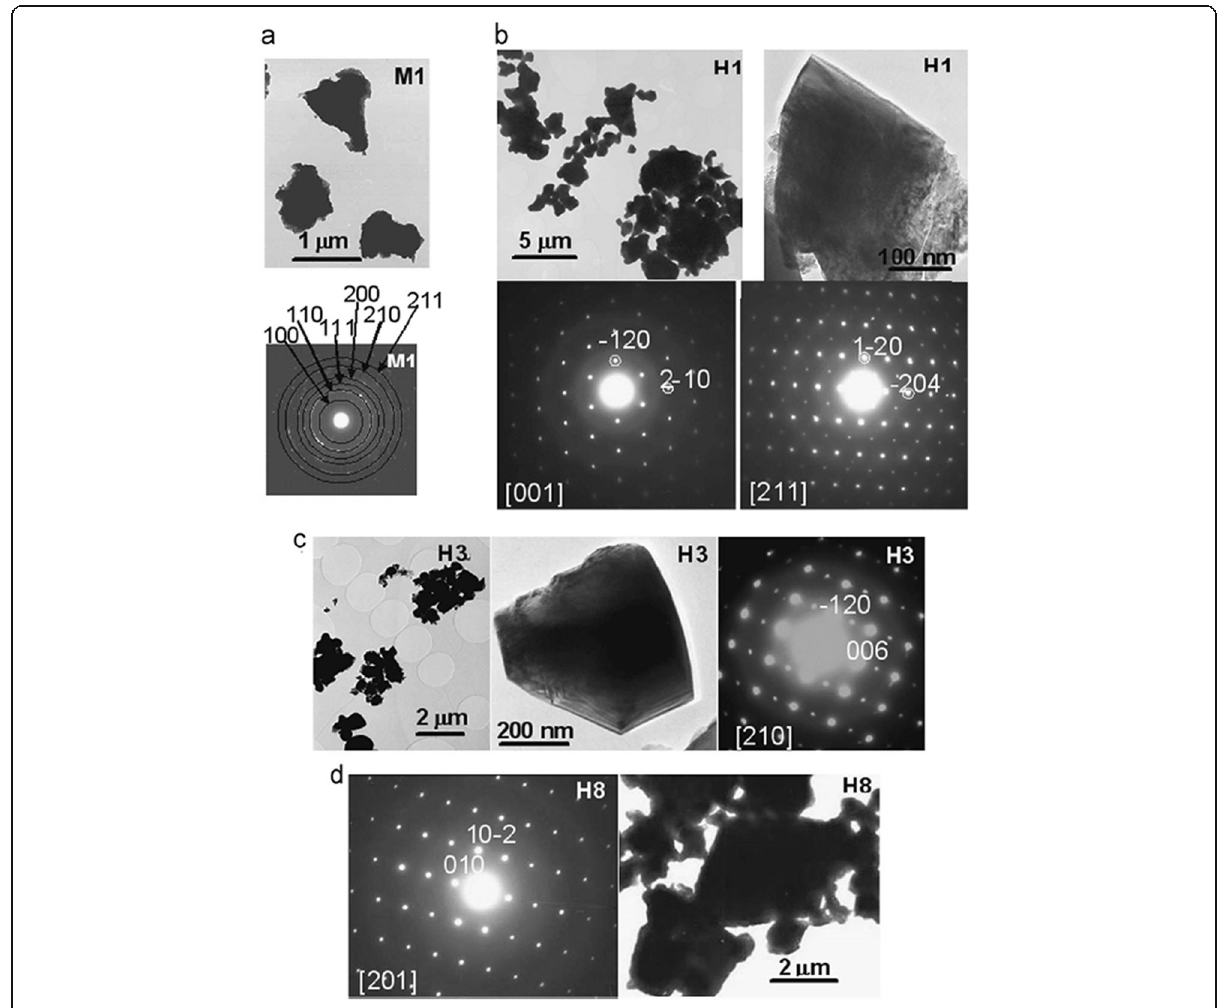
Fig. 6 TEM images and SAED patterns corresponding to a M1 ( x = 0), b H1 ( x = 0), c H3 ( x = 0.50), and d H8 ( x = 1.0) samples. The samples in the La 1-x Sr x MnO 3± δ (0 ≤ × ≤ 1) system with the first step after milling refer to M samples and after heated at 1100 °C under air atmosphere during 12 h refer to H samples. Reproduced with permission of [147]